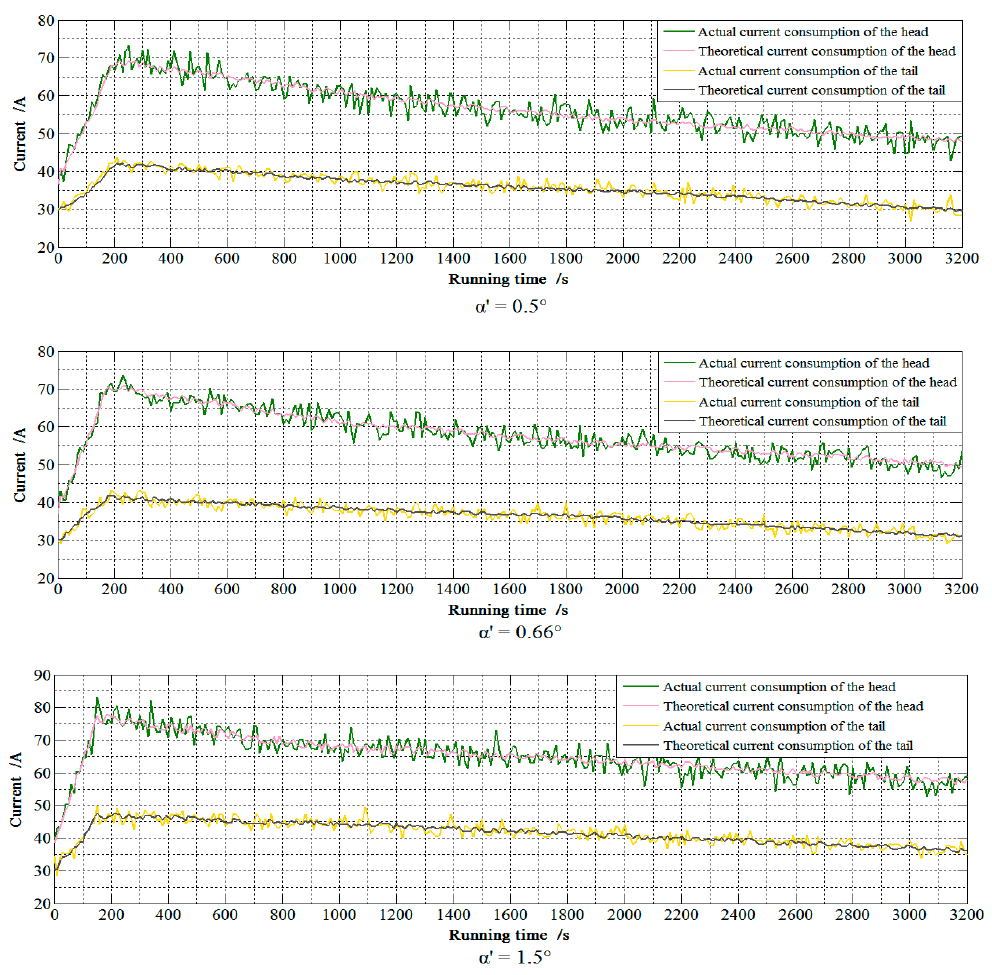
Figure 9. Comparison between the measured and theoretical current of scraper conveyor when m =2.